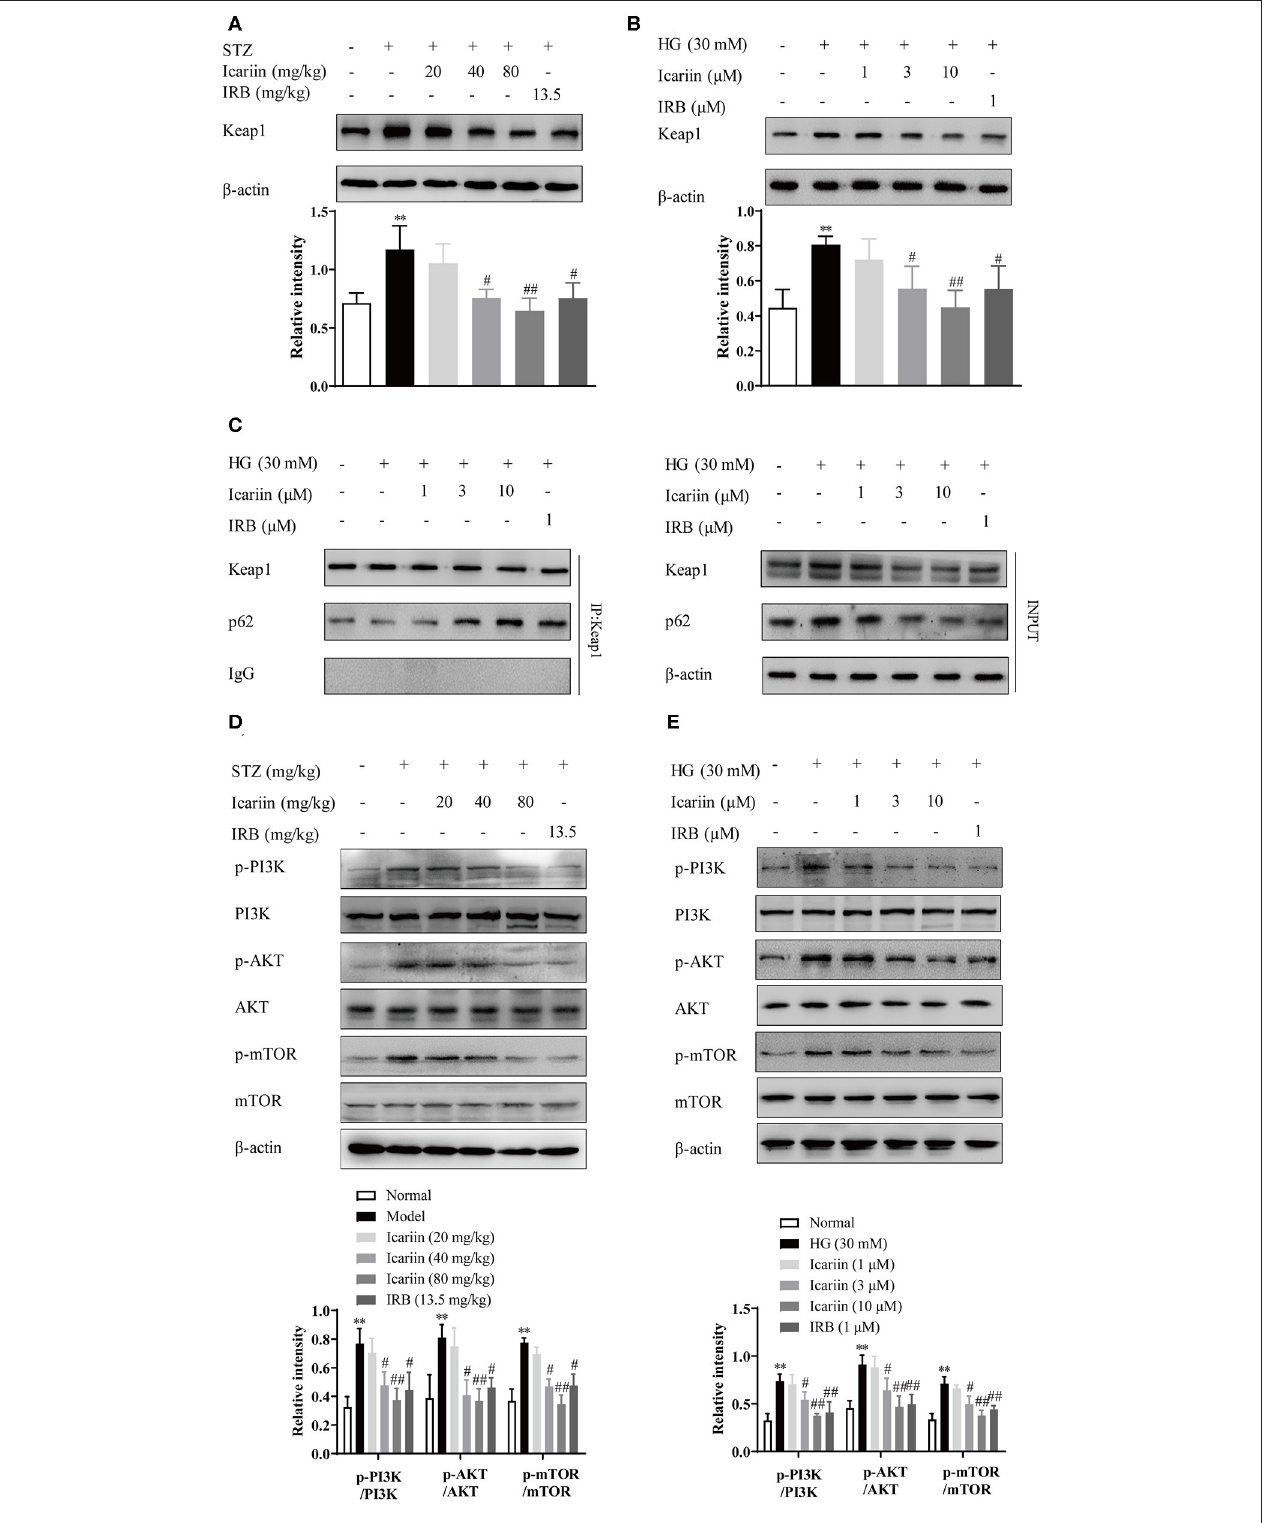
FIGURE 8 | Effect of icariin on HG-induced degradation of Nrf2 by promoting p62-dependent Keap1 degradation. (A,B) Effect of icariin on Keap1 protein level in STZ-induced diabetic rat kidney and high glucose induced HMC. (C) Effect of icariin on the interaction between p62 and Keap1 induced by high glucose in HMC. (D,E) Effect of icariin on phosphorylated and total PI3K, Akt, and mTOR1 protein level in vivo and in vito . Data are expressed as mean ± SD. ** p < 0.01, compared with the normal control group; # p < 0.05, ## p < 0.01, compared with the Model group or HG group.